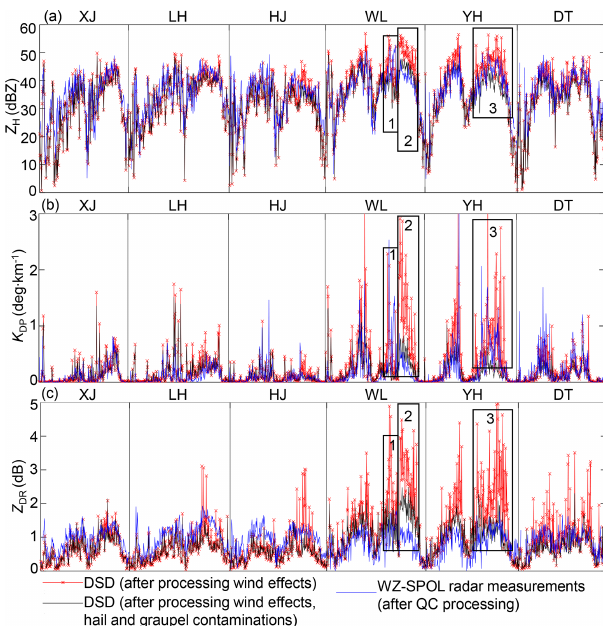
and DSD- H and DSD- DR